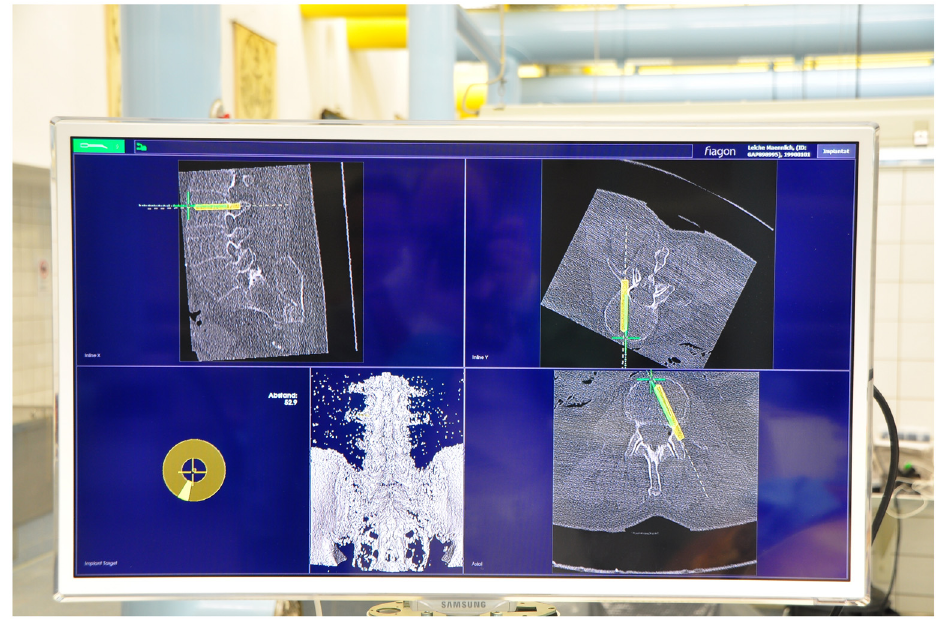
Fig 3. Navigation Planning